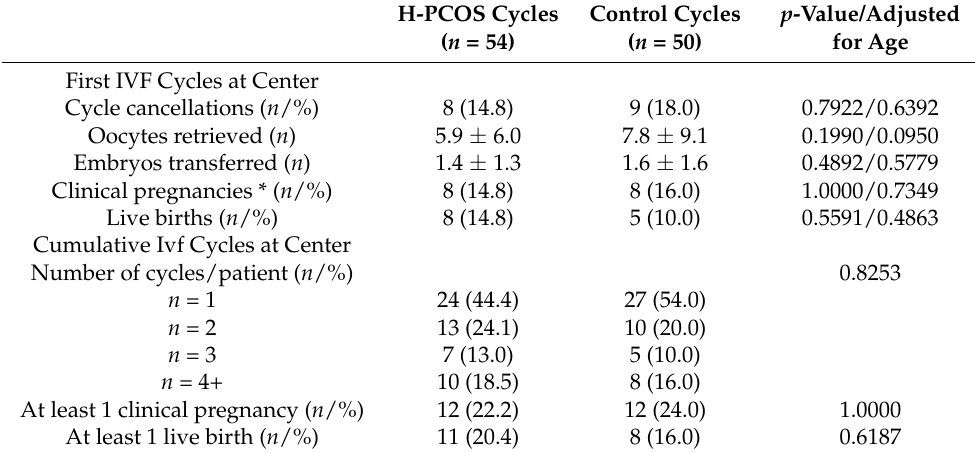
Table 4. IVF cycle